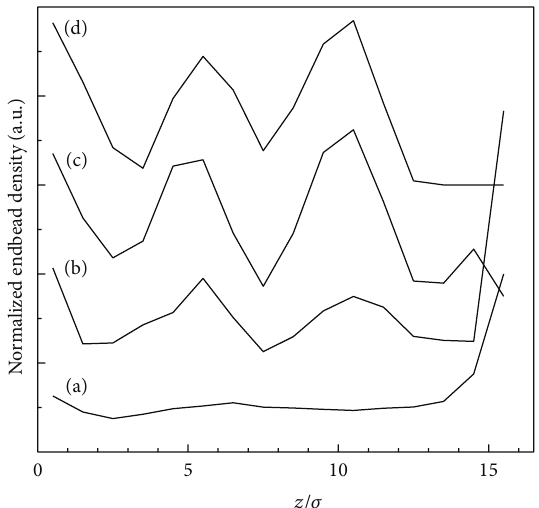
Figure 19: Normalized endbead densities as a function of distance from the surface ( 𝑁 = 10 ) for (a) 𝜀 𝑝 = 𝜀 𝑝 𝑤 = 0 , (b) 𝜀 𝑝 = 𝜀 𝑝 𝑤 = 𝜀 , (c) = 2𝜀 , and (d) 𝜀 𝑝 = 𝜀 𝑝 = 3𝜀 . 𝜀 𝑝 = 𝜀 𝑝 𝑤 𝑤